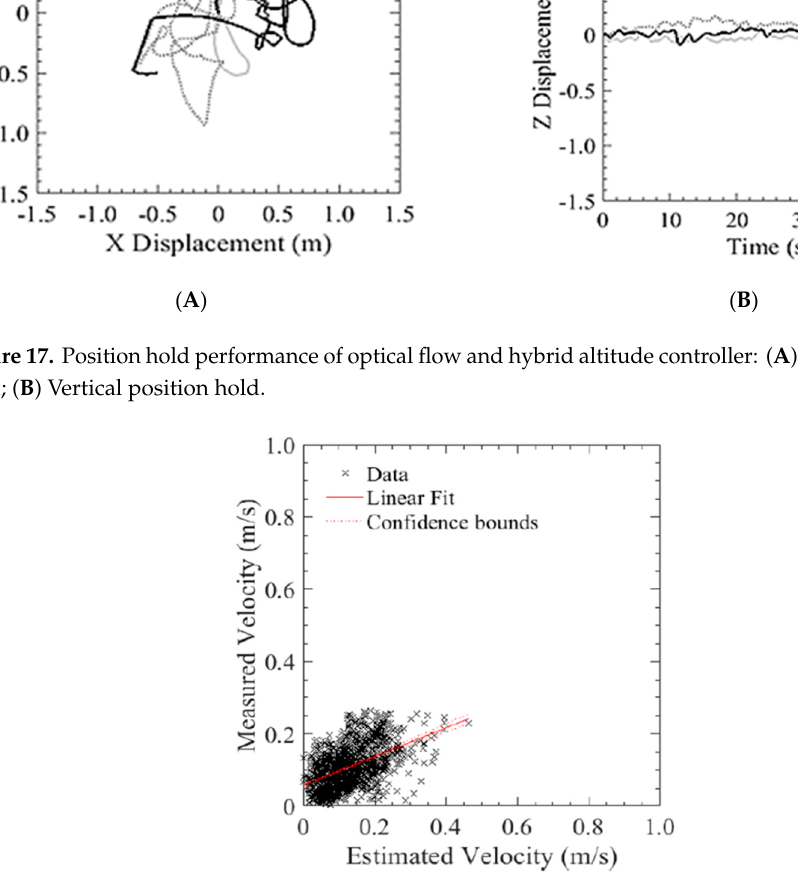
Figure 18. Estimated velocity (from GPS) versus measured velocity (DIC) of the best run for the bridge inspection airframe.